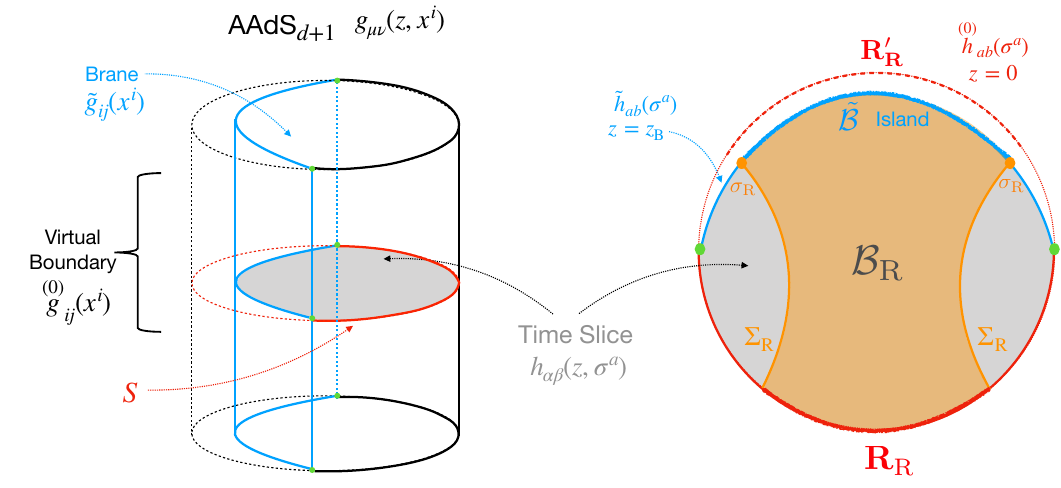
Figure 3 . The full asymptotically AdS d +1 geometry from the right side of the construction in figure 2. The time slice S is introduced in the left panel and detailed in the right panel. We explicitly show various metrics for the different